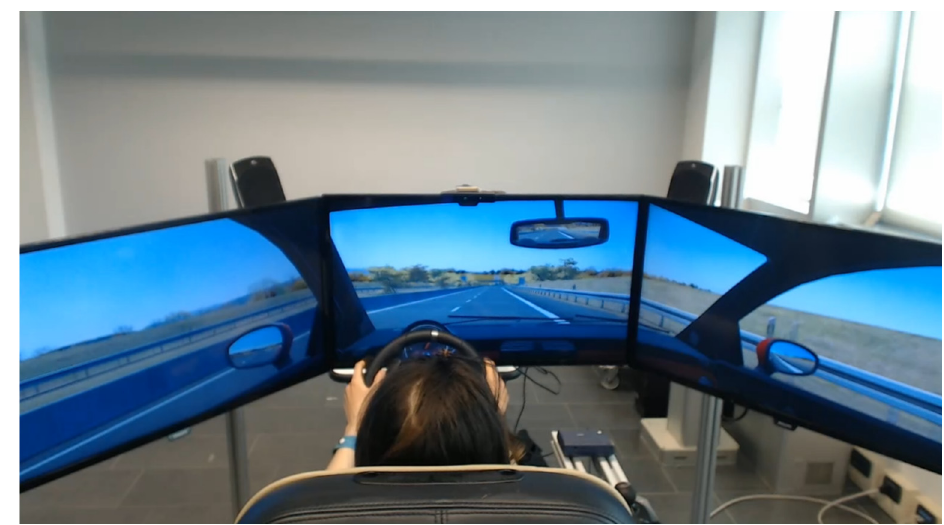
Figure 3. First driving experience.